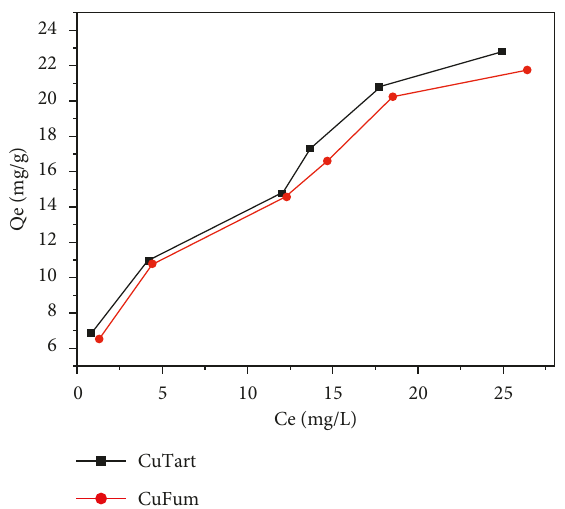
Figure 6: Effect of initial concentration on the adsorption of phenacetin onto CuTart and